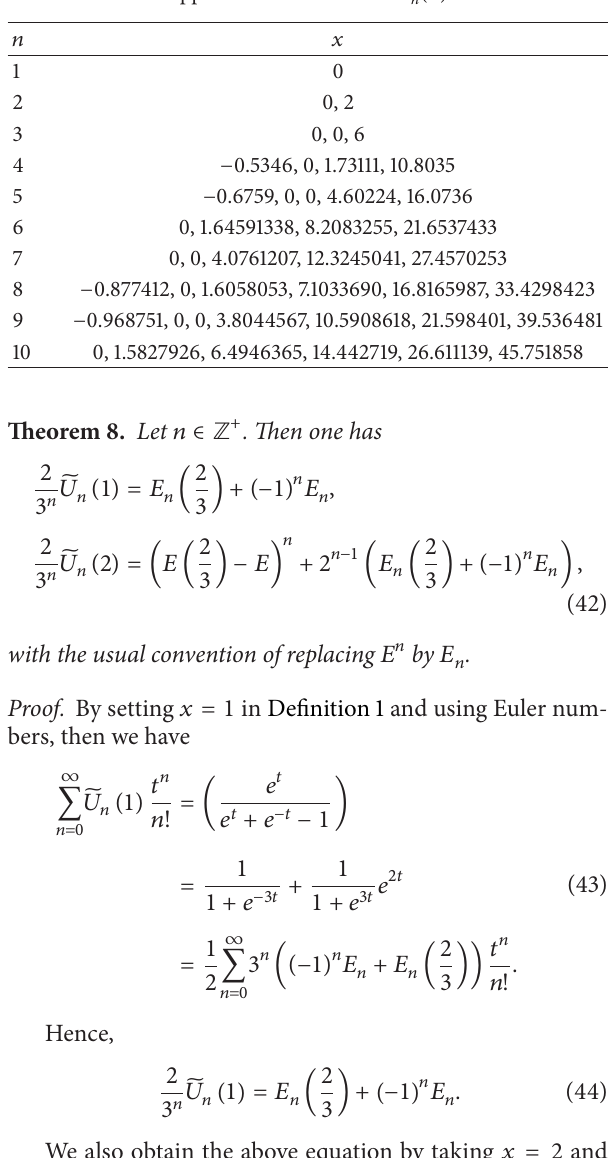
Table 2: Approximate solutions of